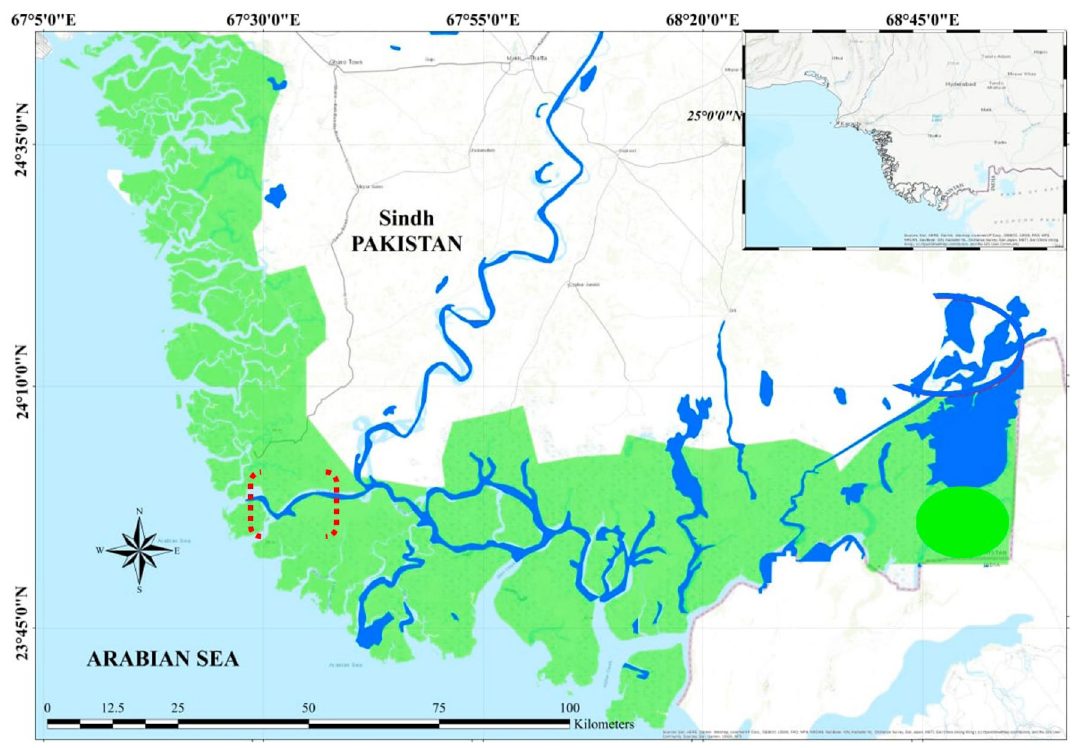
Fig. 1 Red dotted area is mouth of the Indus River Estuary where fish and water quality sampling was carried out in